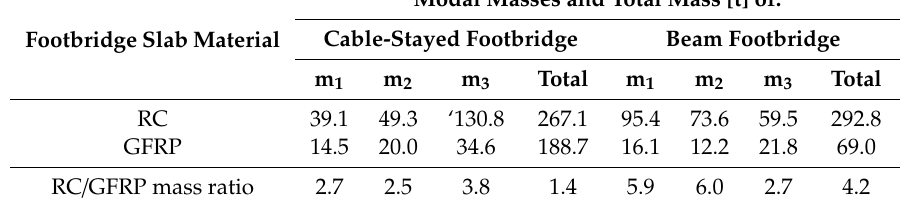
Table 17. Comparison of the maximum accelerations of the footbridges with the traditional RC or the innovative GFRP slab